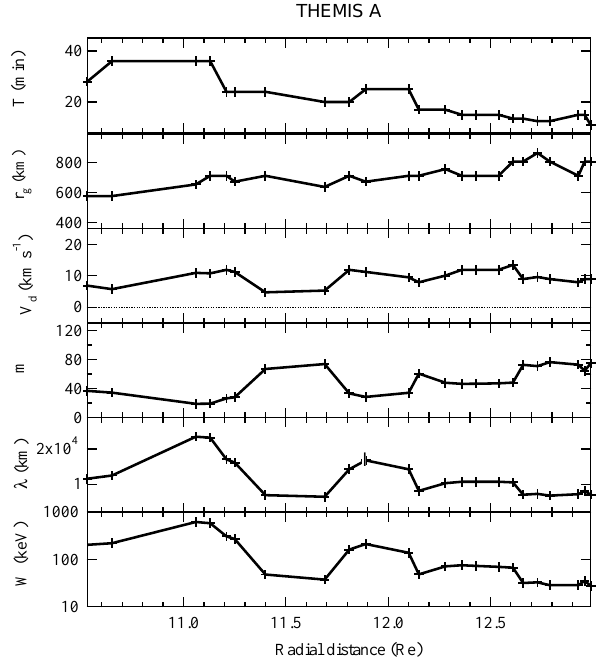
Fig. 8. Particle and wave parameters from 08:00UT to 12:24UT on 7 November 2007 for THEMIS-A. From top to bottom, the panels show the wave period, proton Larmor radius, wave phase velocity, azimuthal wave number, wavelength and energy of resonant drift- bounce ions versus radial